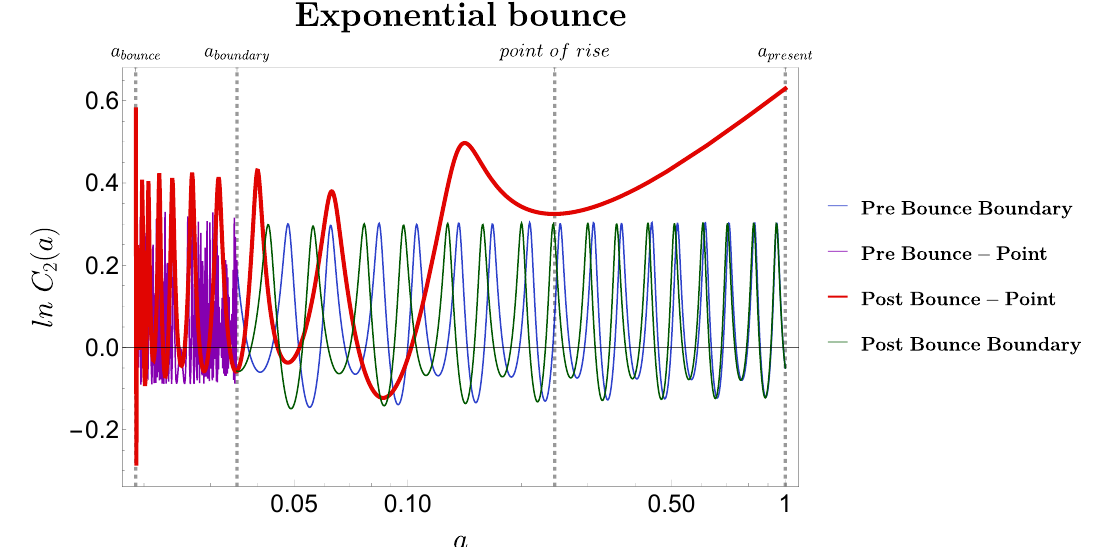
Figure 32: Logarithm of geodesically weighted complexity in different regions against scale factor.